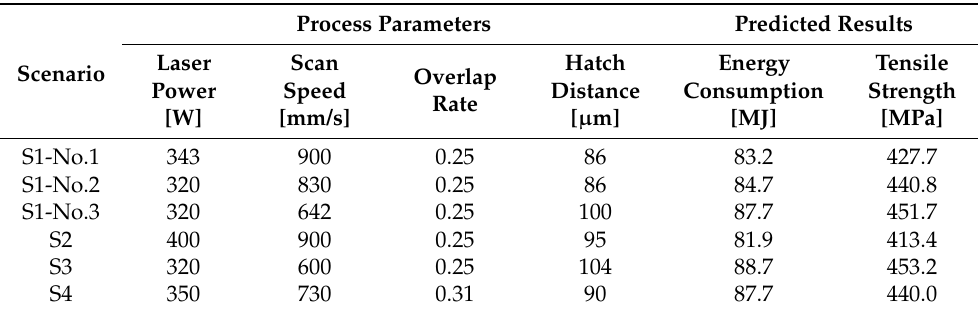
Table 8. Comparisons of process parameters and optimized results for different scenarios of the SLM process. Process Parameters Predicted Scenario